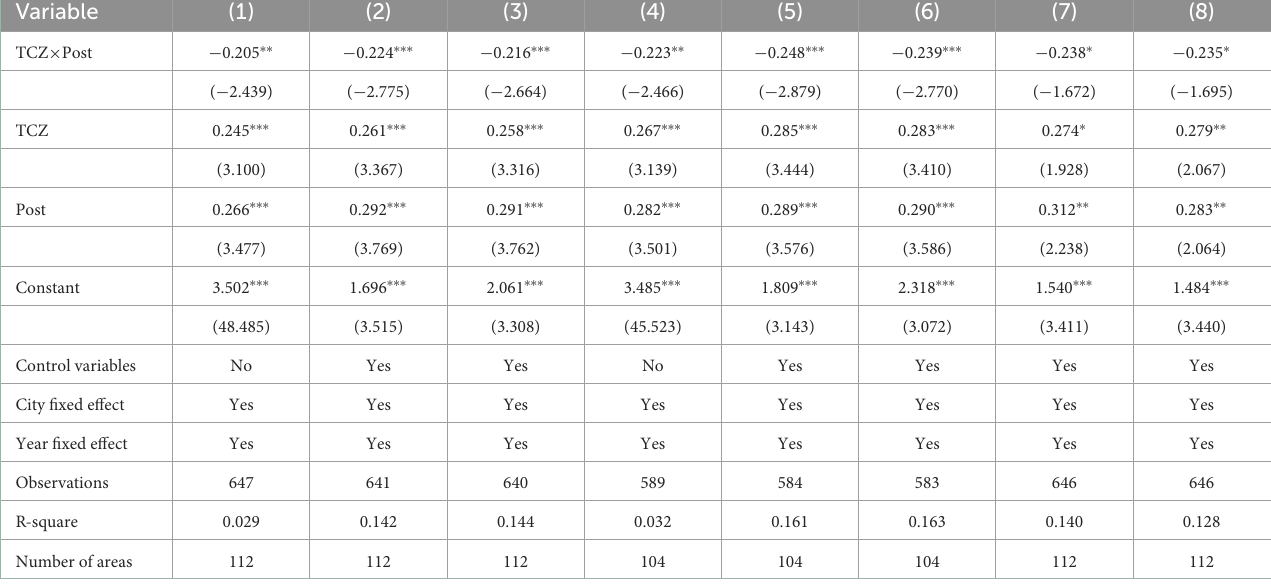
TABLE 4 Results of robustness